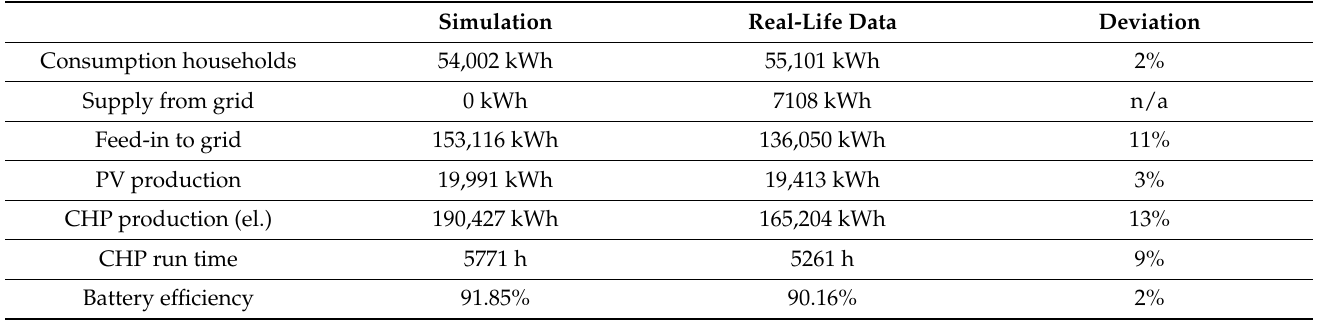
Table 6. Simulated and recorded data for the building block from May 2019 to April